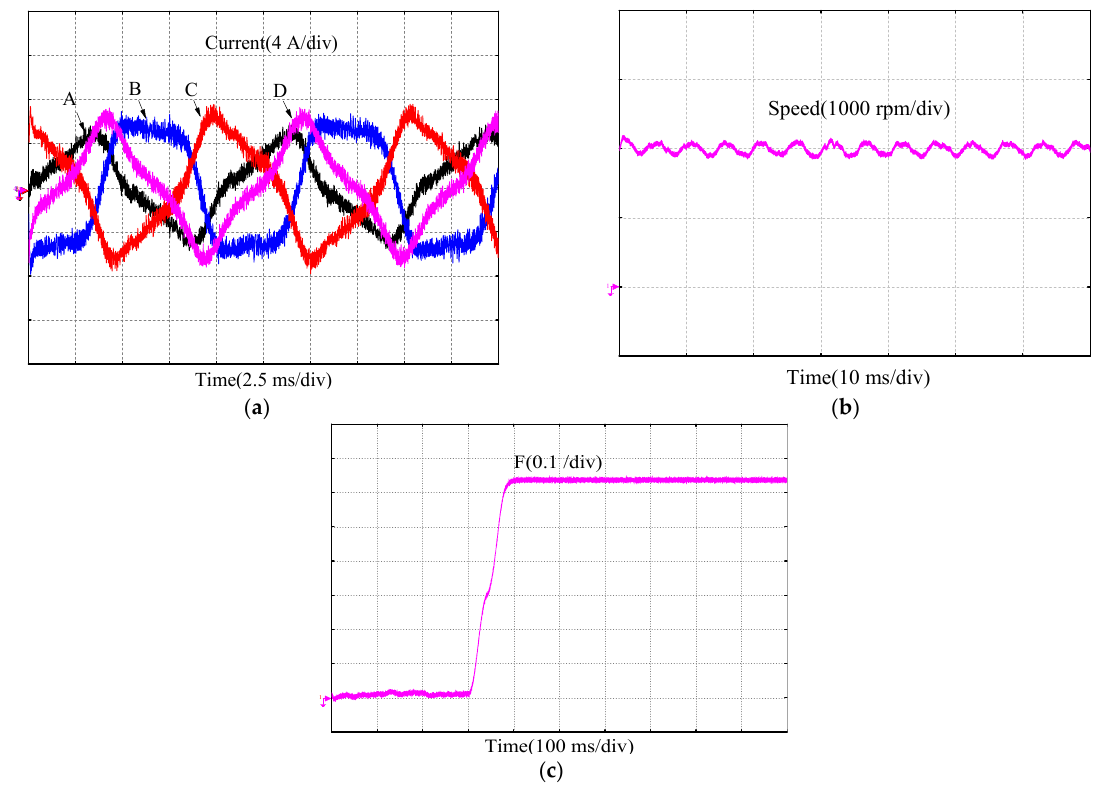
Figure 16. Motor waveform during F-phase open circuit fault. ( a ) Current waveform. ( b ) Speed waveform. ( c ) Fault characteristic value.